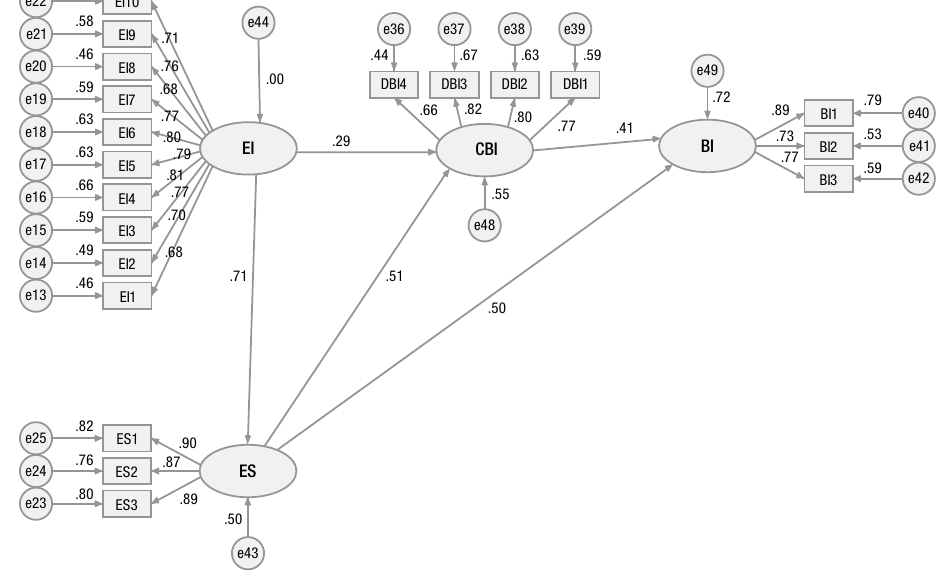
Fig. 3. Standardized parameter